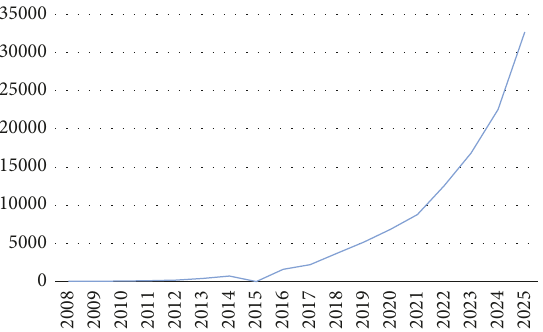
Figure 5: Solar energy supply in the Netherlands by year, gigawatts per hour. Source: IEA; author’s calculations.